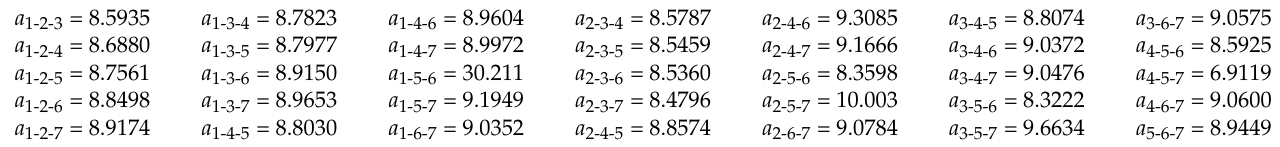
Table 5. The set of a r - s - t values of the probable theoretical elastic deformation at the compression of a loaded pole, determined based on k = 7 FEA analyses with different discretization levels (in µ